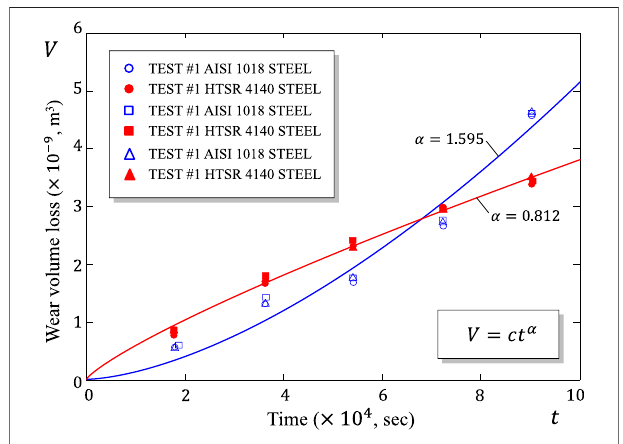
FIGURE 1 | Volume loss vs. time on linear coordinates with best fi t power-law lines for Delrin against two counterparts (based on the experimental data taken obtained by Viswanath and Bellow (1995)).